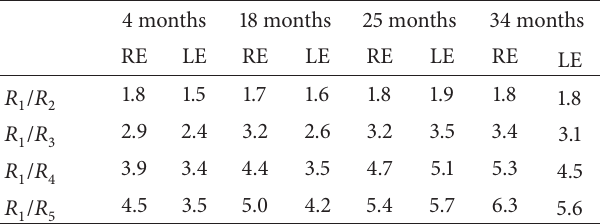
Table 2: mfERG rings ratios